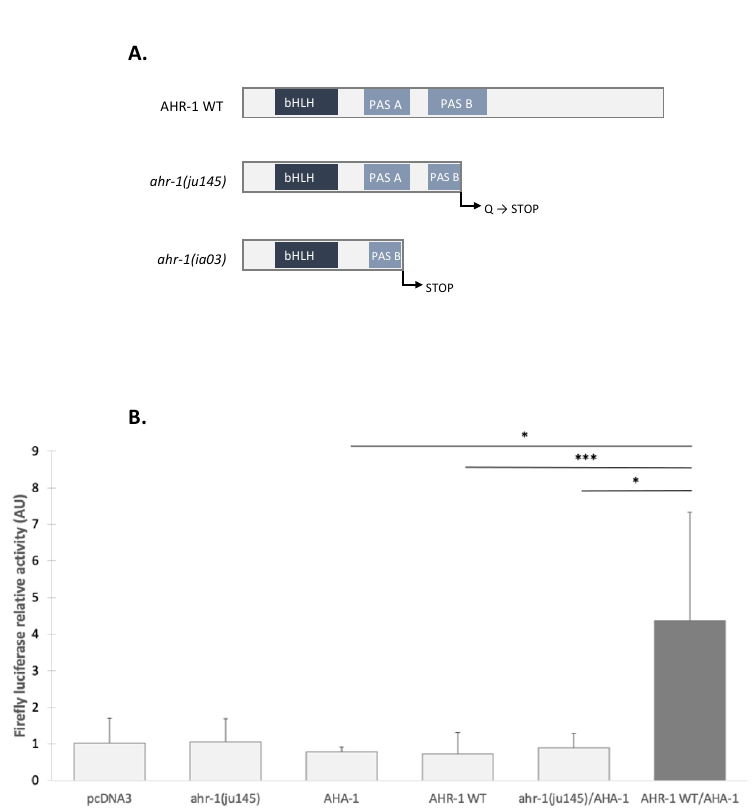
Figure 2. Requirement of AHR-1 and AHA-1 for transcriptional activity. ( A ) Structure of AHR-1 WT, ahr-1(ju145) and ahr-1(ia03) proteins. The 602 amino acids AHR-1 WT protein is truncated in